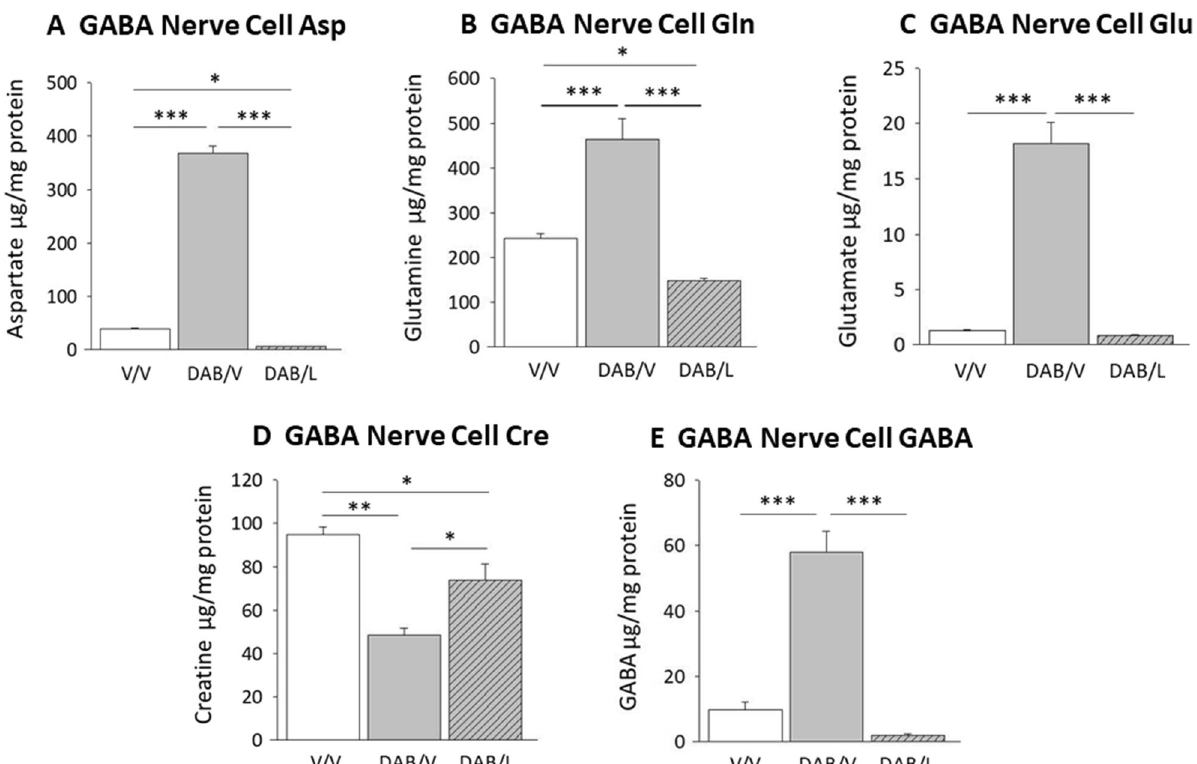
Figure 2. Effects of l-lactate on VMN GABAergic neuron glucogenic and neurotransmitter amino acid concentrations following intra-VMN administration of the glycogen phosphorylase inhibitor 4-dideoxy- 1,4-imino-d-arabinitol (DAB). Groups of rats (n = 4/group) were infused (2 min) into the VMN with DAB (150 pM), then infused 10 min later with vehicle (V) or l-lactate (100 nM). For each treatment group, VMN GAD-ir nerve cell lysates from individual subjects were combined to create triplicate samples for LS–ESI–MS analysis of each target amino acids: Data show mean GABA nerve cell aspartate (Asp; A ), glutamine (Gln; B ); glutamate (Glu; C ); creatine (Cre; D ); and GABA ( E ) amino acid concentrations ± S.E.M. for the following treatment groups: V/V (solid white bars); DAB/V (solid gray bars); DAB/lactate (diagonal-striped gray bars). * p < 0.05, ** p < 0.01, ** p < VMN GABA neuron Cre levels were suppressed by DAB, but were normalized in DAB- plus lactate-treated ani- mals [F (2,6) = 14.5; p = 0.002]. DAB caused lactate-reversible augmentation of GABA amino acid levels in VMN GABAergic neurons (Fig. 2E; F (2,6) = 58.8; p = 0.0001). NO nerve cell Cre levels were significantly decreased by DAB, and were further suppressed by DAB plus lactate treatment (Fig. 3D; F (2,6) = 230.2; p < 0.0001). DAB increased nitrergic neuron GABA concentrations, a response that was partially reversed by lactate (Fig. 3E; F (2,6) = 127.1; p < 0.0001). Figure 4 depicts effects of GP inhibition on VMN astrocyte amino acid content. DAB suppressed astrocyte Asp (Fig. 4A; F (2,6) = 71.2; p < 0.0001) and Gln (Fig. 4B; F (2,6) = 74.4; p < 0.0001) concentrations by lactate-dependent or -independent mechanisms, respectively. Astrocyte Glu levels were refractory to DAB/V or DAB/L treatment (Fig. 4C; F (2,6) = 0.38; p = 0.697). DAB suppressed astrocyte Cre content; levels of this amino acid were further diminished by DAB plus lactate [DAB/L versus DAB/V] (Fig. 4D; F (2,6) = 128.3; p < 0.0001). Astrocyte GABA content was decreased to a comparable extent by either DAB/V or DAB/L treatment (Fig. 4E; F (2,6) = 149.1; p < 0.00010. Data presented in Fig. 5 show that stereotactic-targeted delivery of DAB to the VMN (solid gray bar) resulted in significant augmentation of tissue glycogen content compared to the V/V control group (solid white bar) (F (2,6) = 7.9; p = 0.0045). VMN glycogen levels were significantly decreased in animals treated with DAB/L versus DAB/V (diagonal-striped gray bar).